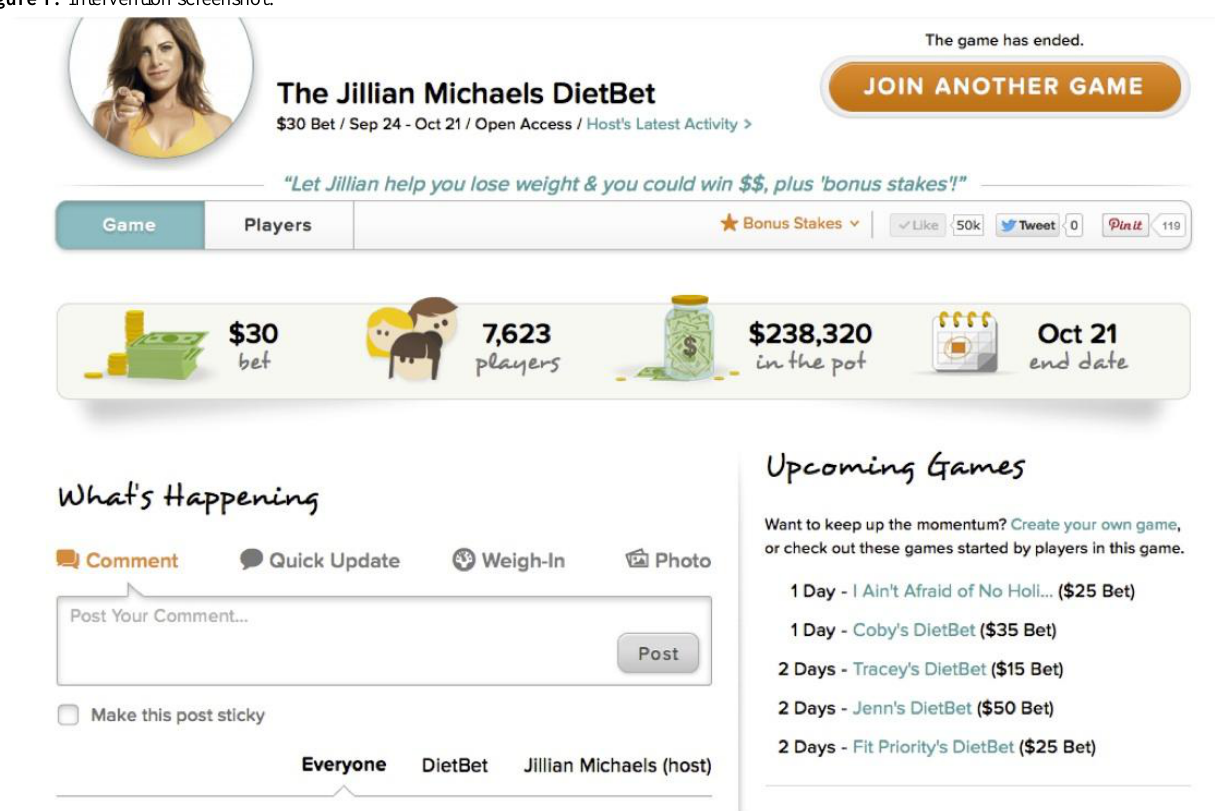
Figure 1. Intervention